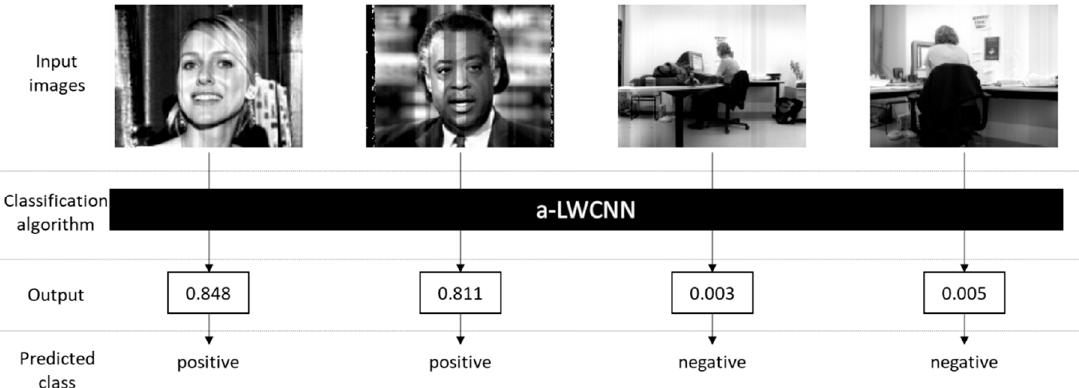
Figure 13. Examples of the face recognition process.